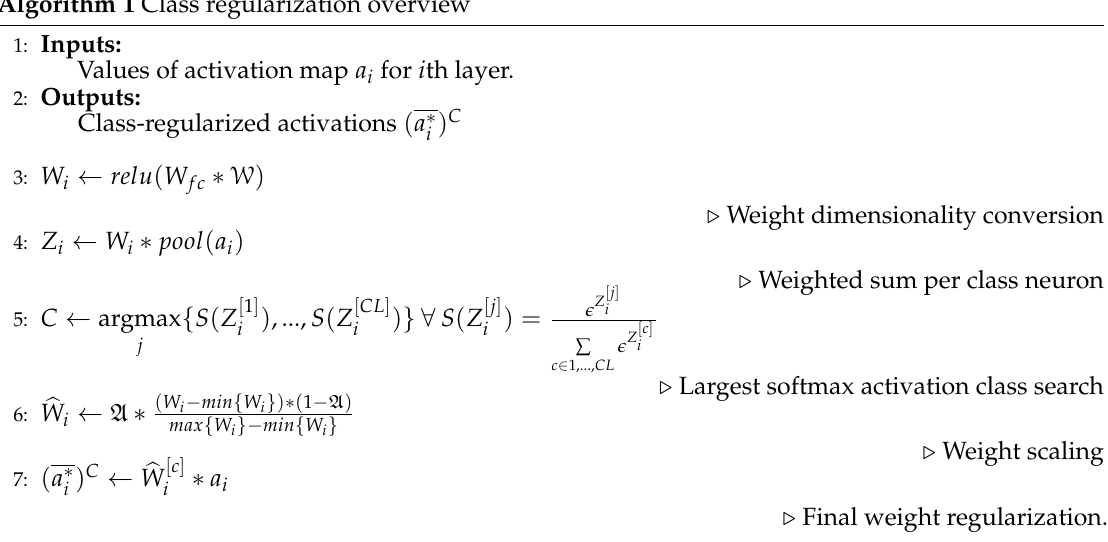
Algorithm 1 Class regularization